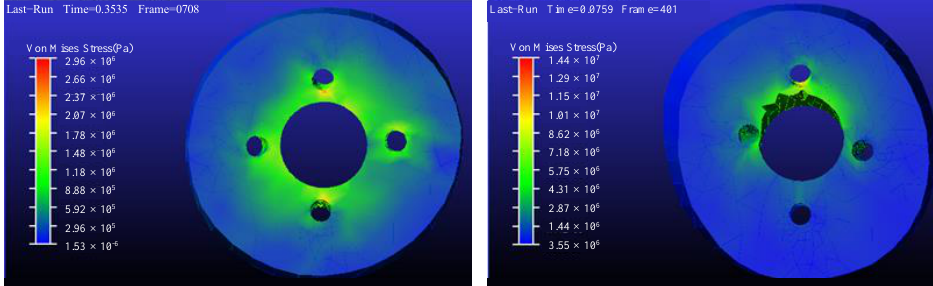
Figure 7. Stress cloud diagram for 4 and 2 cups.